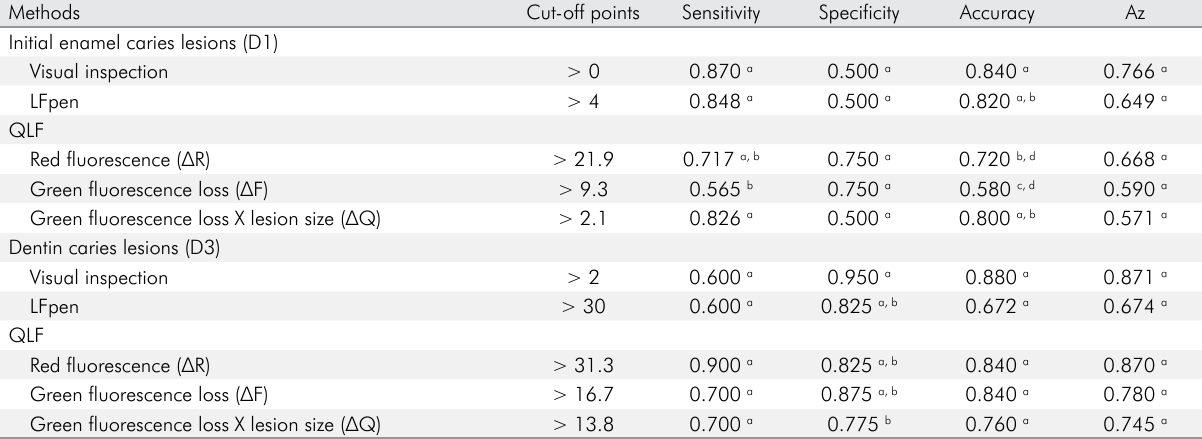
Table 3. Performance of methods for detecting occlusal caries lesions at different thresholds regarding the lesion depth.